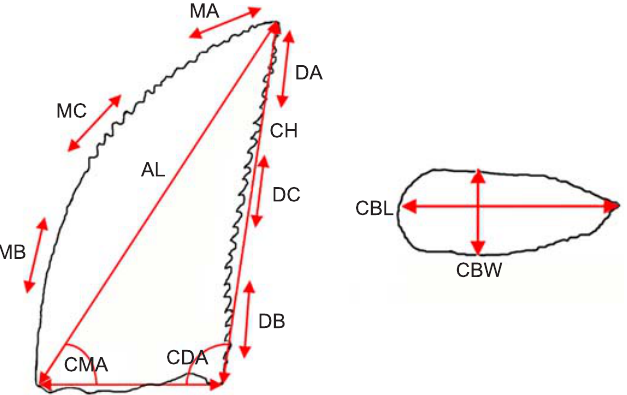
Fig. 2. Tooth measurements and dimensions used in this study. Theropod dental anatomy and variables used, in lateral and basal views (redrawn from Smith et al. 2005). AL, apical length; CA, crown angle; CBL, crown base length; CBR, crown base ratio; CBW, crown base width; CH, crown height; CHR, crown height ratio; DA, distal denticles in the apical section. DB, dis- tal denticles in the basal section. DC, distal denticles in the central section. DSDI, denticle size difference index. MA, mesial denticles in the apical section. MB, mesial denticles in the basal section. MC, mesial denticles in the central